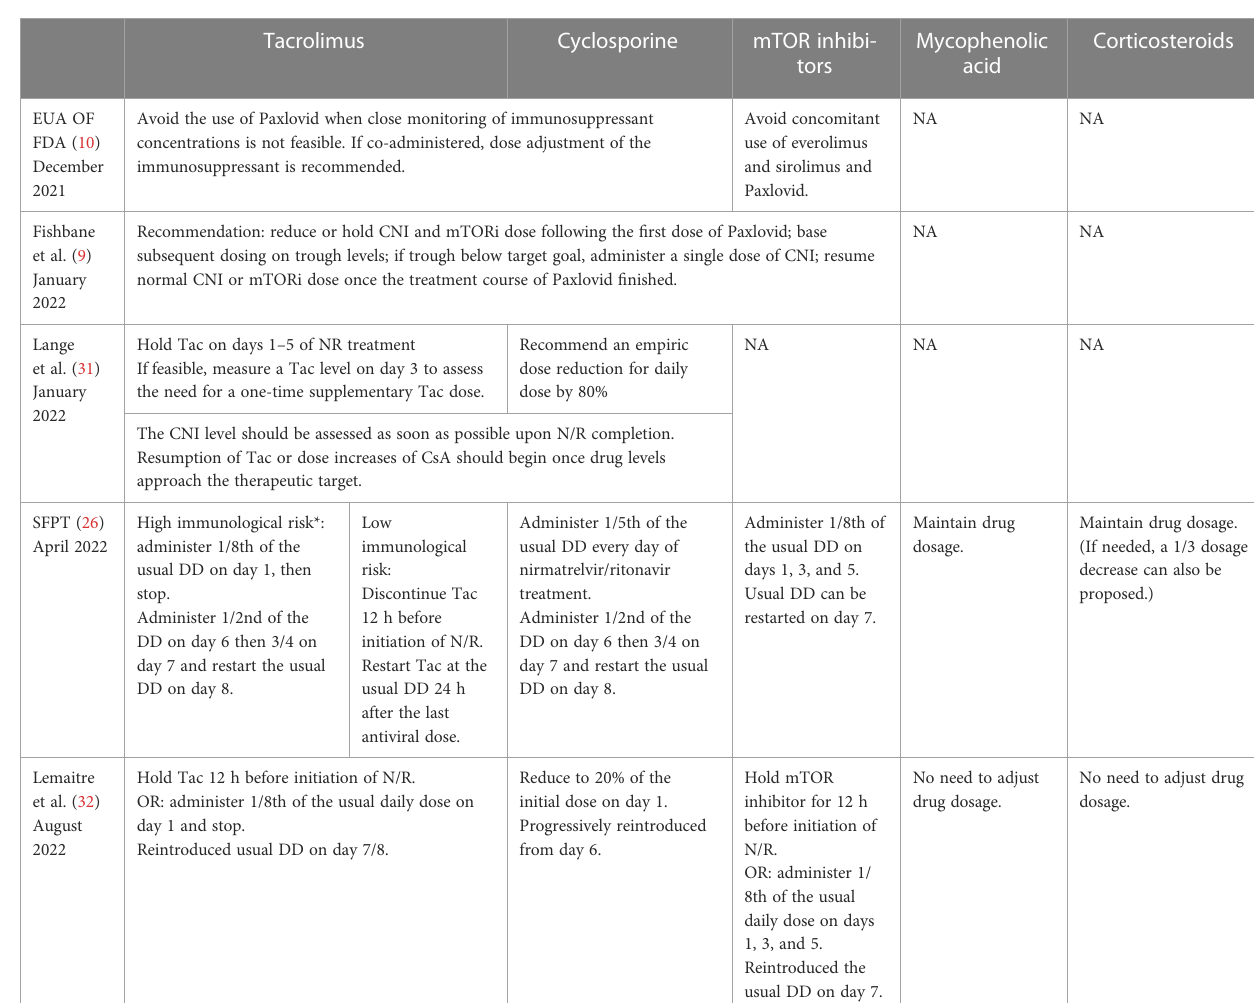
TABLE 4 A summary of adjustment strategies of immunosuppressive